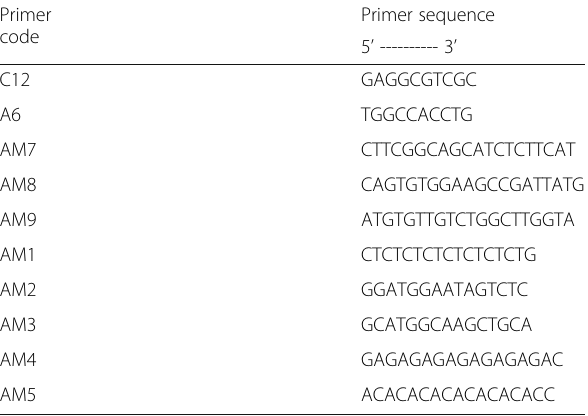
Table 1 Sequence of primers used in randomly amplified polymorphic DNA (RAPD) analysis Primer